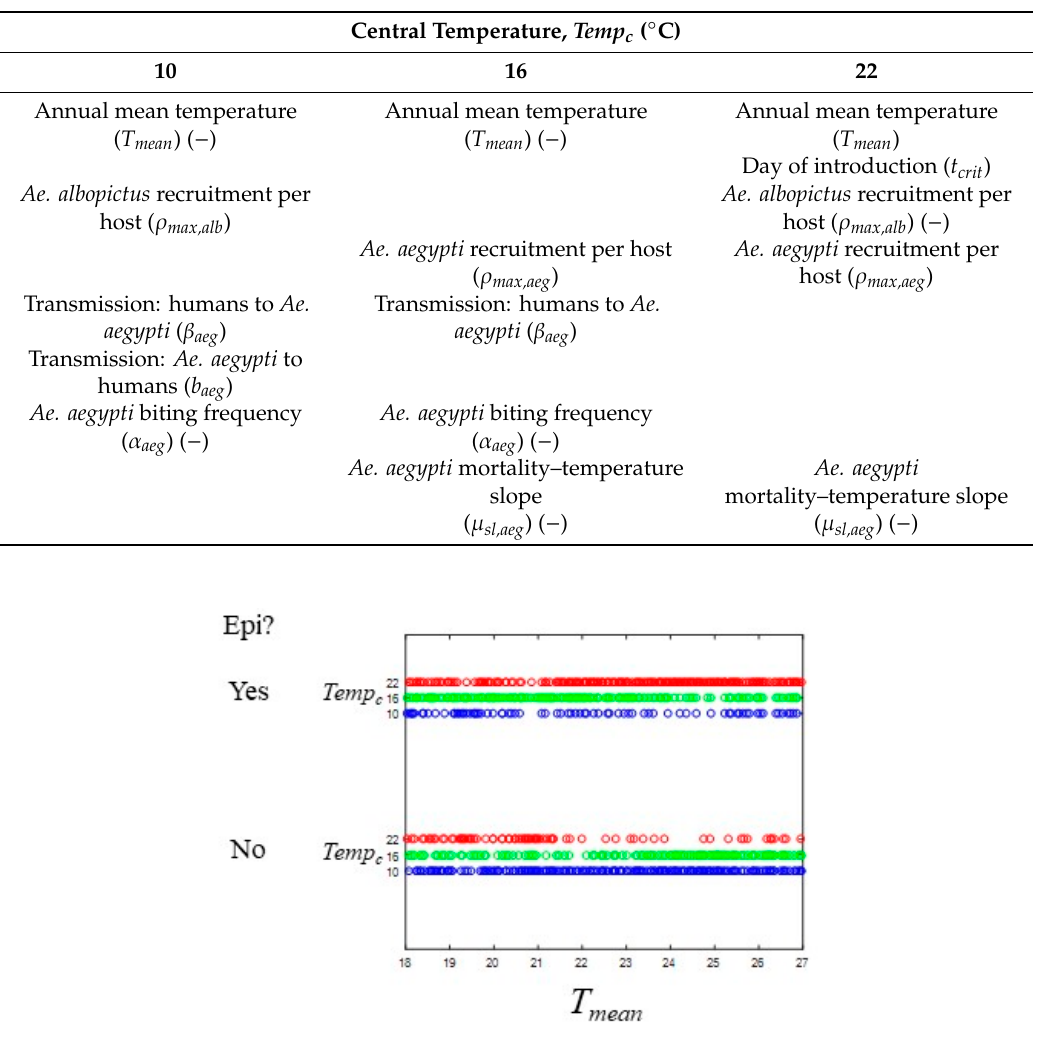
Table 3. Top five parameters influencing likelihood of epidemics with different values of the central temperature in the mortality function, Temp c . Parameters identified using full, main effects logistic regression model and ranked by p -value. Negative regression coefficients indicated by (-).